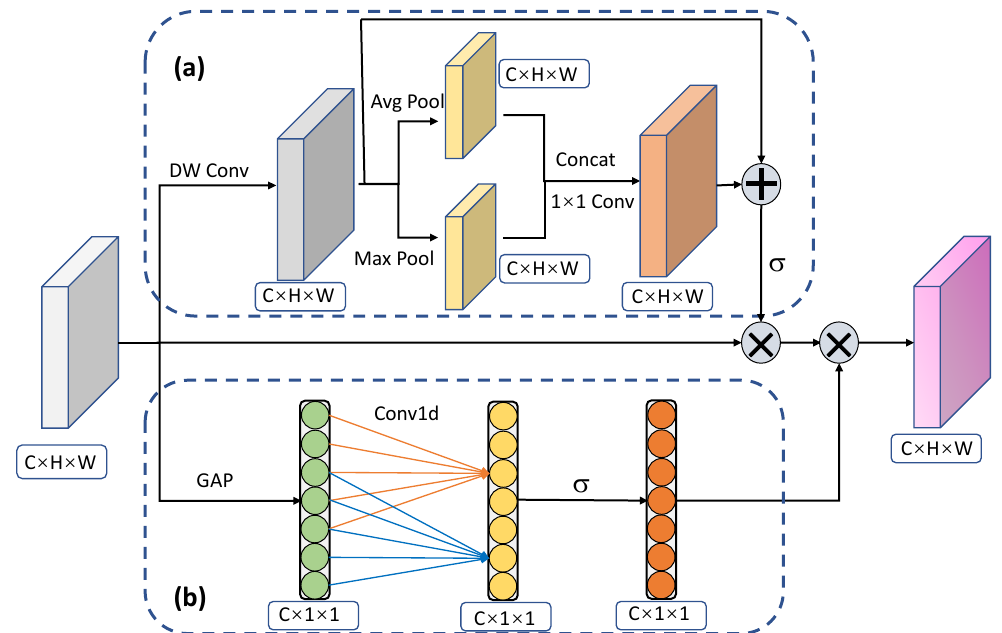
Figure 3. The structure of adaptive weight assignment module based on improved dual attention. It is mainly composed of two parts: ( a ) spatial weight attention and ( b ) channel weight attention. DW Conv means the depthwise convolution. Avg Pool and Max Pool mean average pooling and max pooling, respectively. GAP means global average pooling. σ means the sigmoid